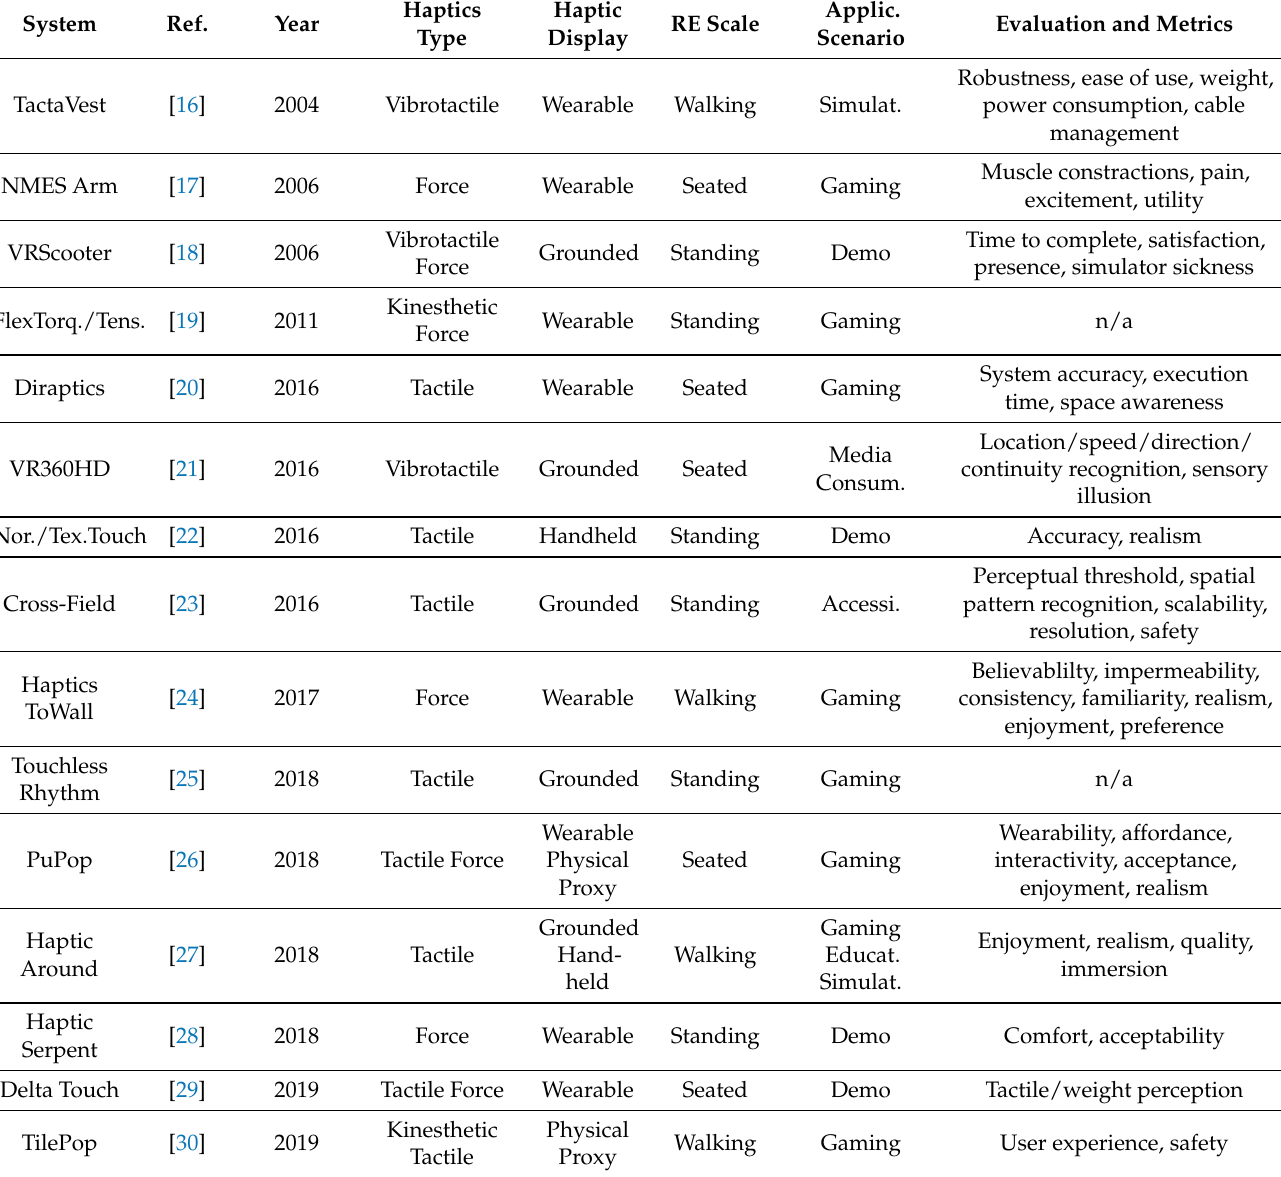
Table 1. Condensed results of our systematic selection and